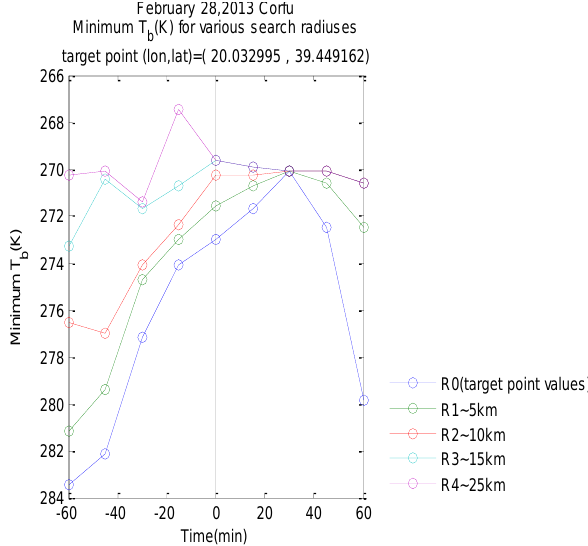
Figure 2. The temporal (60min prior and after waterspout forma- tion) distribution of BT during 28 February 2008 waterspout event for all examined